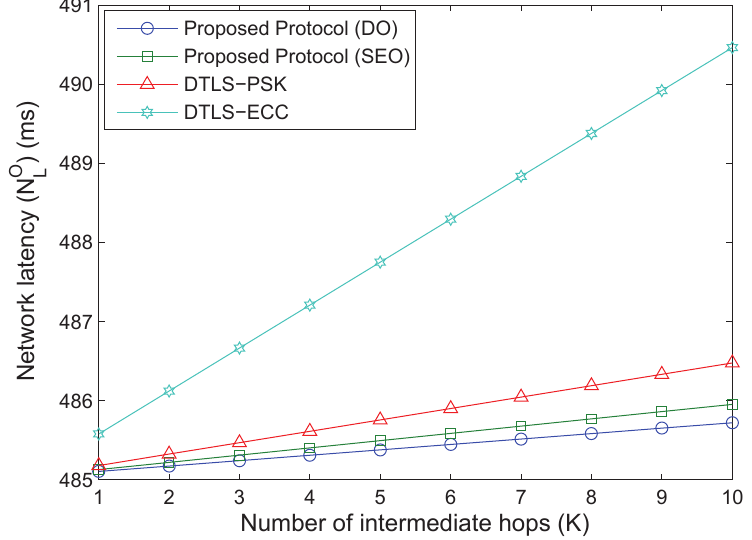
Figure 16. Network latency (ms) vs. the number of intermediate hops.